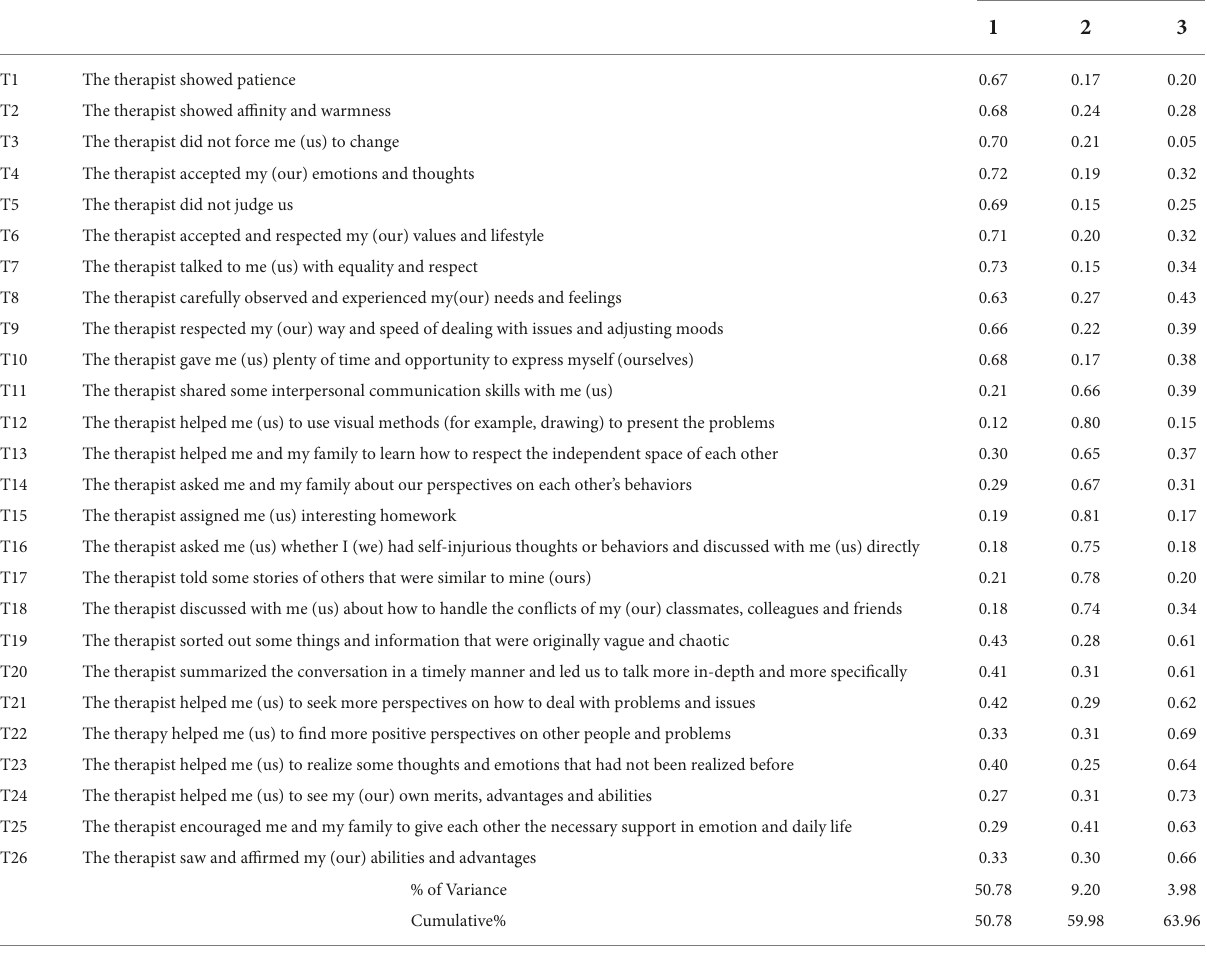
TABLE 2 Results of the principal component